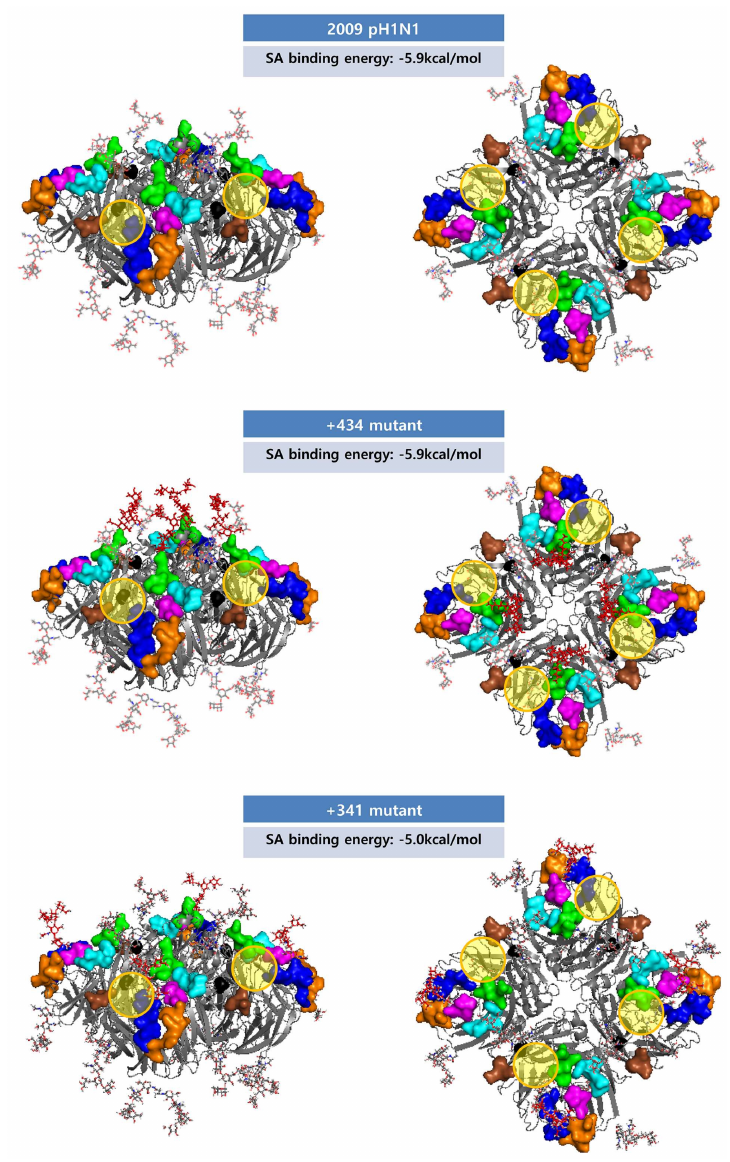
Figure 9. Glycosylated NA tetramer structures and the sialic acid binding affinities. The NA antigenic sites AS1, AS2, AS3, AS4, AS5, AS6, and AS7 are shown in orange, blue, magenta, cyan, green, brown, and black, respectively. The newly added glycans at positions 434 and 341 are marked in red. The predicted sialic acid binding affinities are shown for the NA tetramer structure. The binding sites are represented by yellow